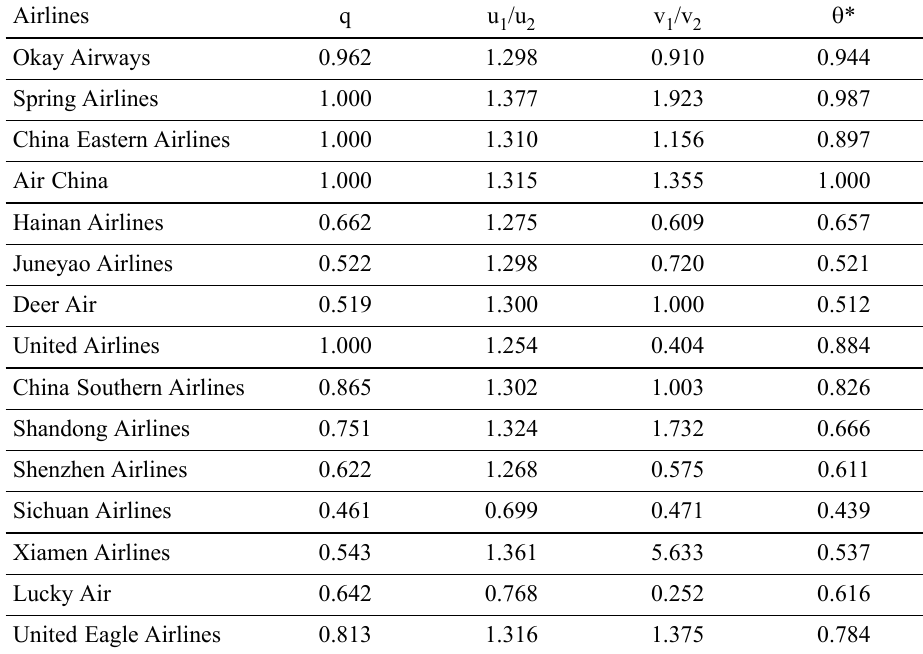
Table 17. Results and weight ratios of Chinese airlines’ relative efficiency from Group-making Model based on DEA with Restrained